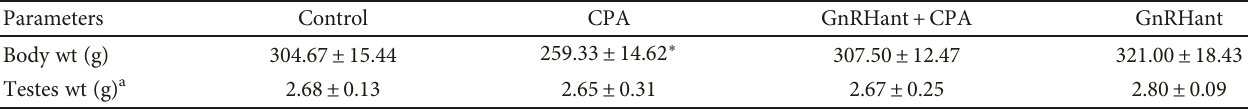
Table 1: Body and testes weights.